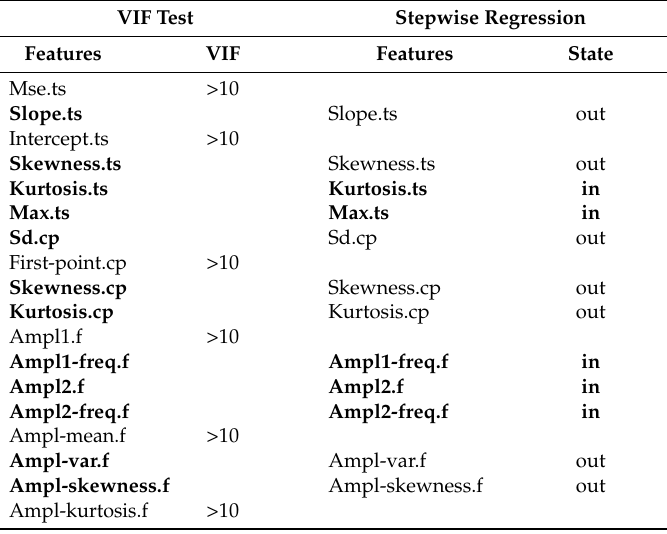
Table 4. Feature